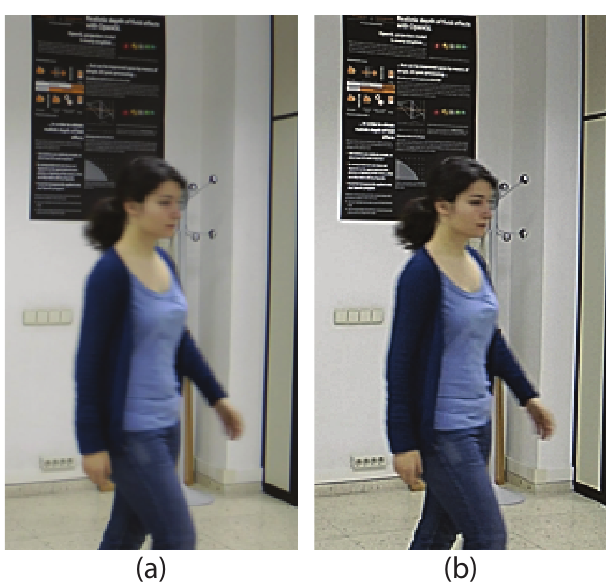
Figure 6. Example of use of the deblurring tools. ( a ) Original image; ( b ) deblurred image. Similarly to the case of the navigation window, the details regarding the use of all of the functions included in the labeling window appear in the user manual that can be downloaded along with TSLAB